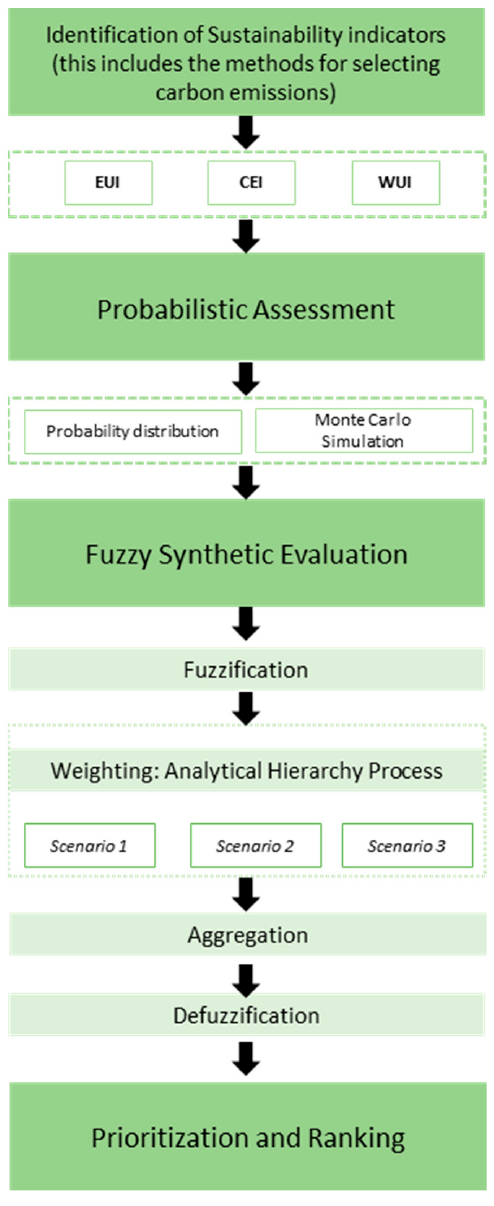
Figure 1. Probabilistic fuzzy synthetic framework.